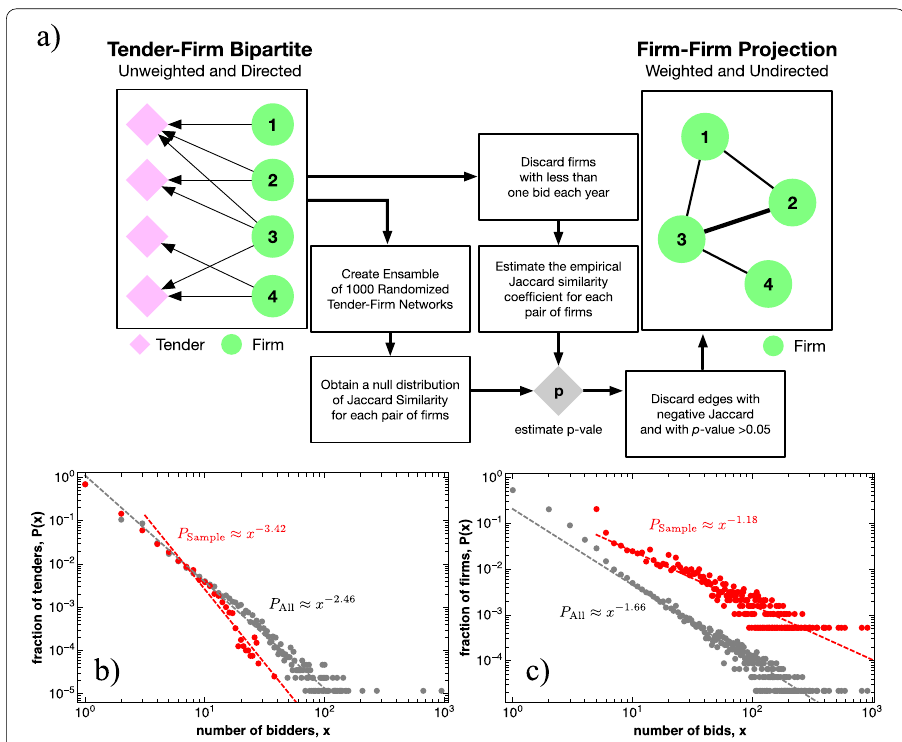
Fig. 1 Panel a , graphical representation of the process employed to infer the Firm–Firm co-bidding network. Panel b , comparison between the frequency of bidders per tender in the original data set (gray) and in the working data set (red) after filters have been applied. Panel c , comparison between the frequency of bids per firm in the original data set (gray) and in the working data set (red) after filters have been applied. In panels ( b ) and ( c ) dashed line represents the OLS regression lines, the domain of the line indicates the domain used for fitting the